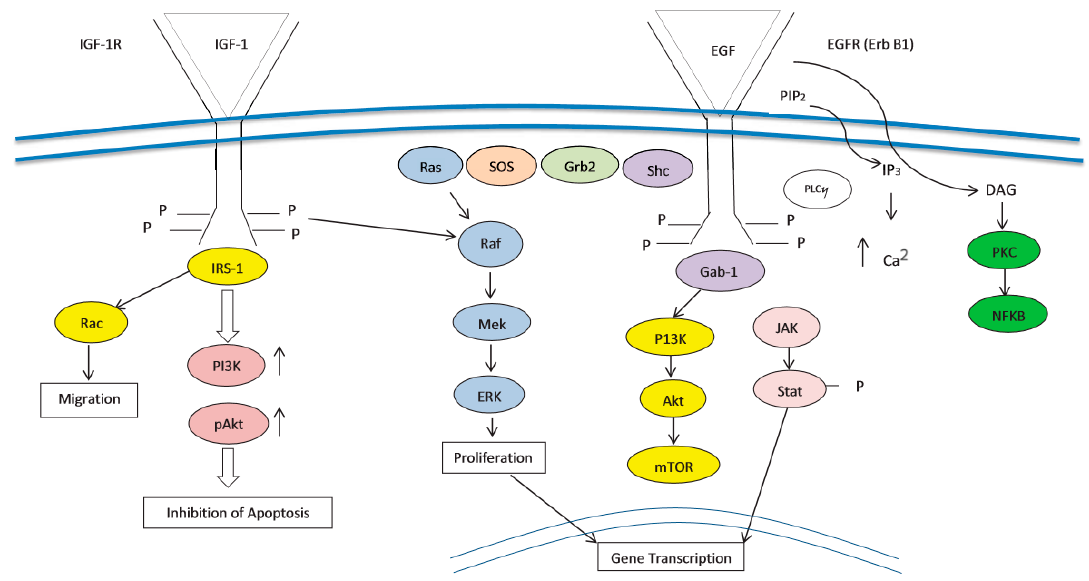
Figure 2. Convergence of IGFR and EGFR Signaling. Rationale for dual blockade of the receptors.